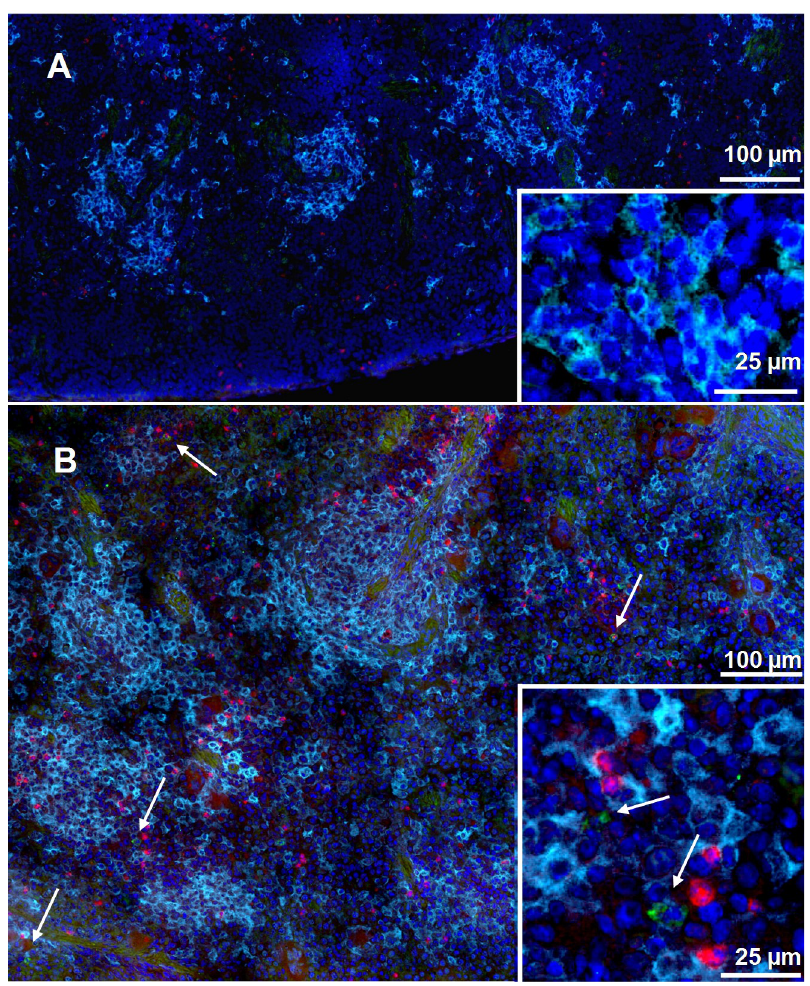
Fig 1. IFN- γ -producing dendritic cells increase in spleens upon Ft LVS infection. Rag1 KO mice were infected with 10 5 GFP-LVS for four days. Spleens from non-infected (A) and GFP-LVS infected (B) mice were sectioned and prepared for immunohistochemistry staining. Anti-mouse IFN- γ (red) and anti-mouse CD11c (cyan) were used as primary antibodies; nuclei stained with DAPI appear dark purple. An anti-GFP polyclonal antibody (green) was used to enhance the signal from LVS. Arrows indicate GFP-LVS. Images are representative of those evaluated in three